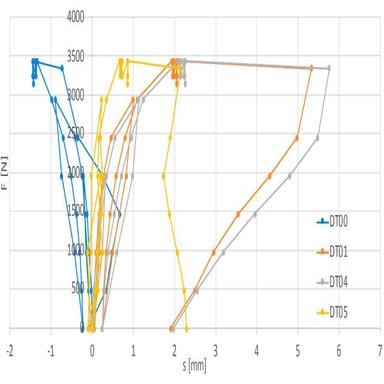
Unreinforced vault: load-displacement diagrams.